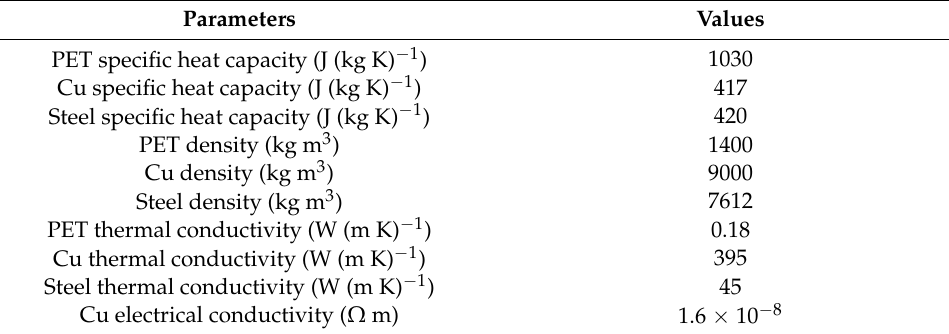
Table 1. Properties adopted to model the heating